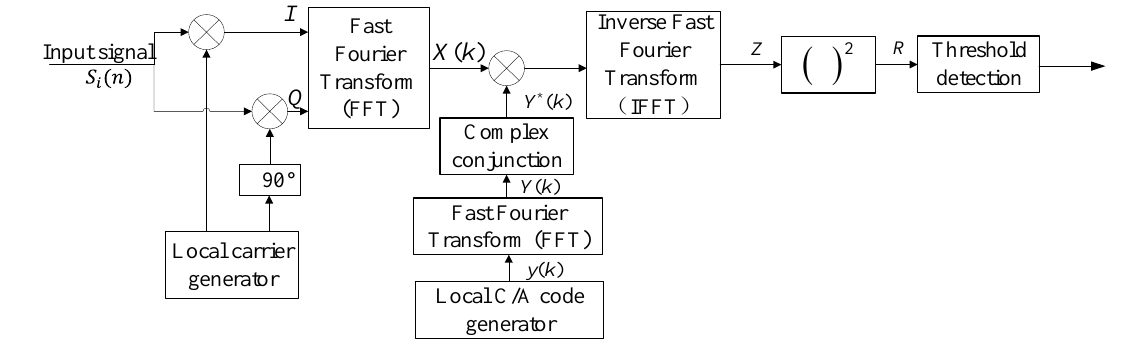
Figure 2. The schematic diagram of the parallel code phase search algorithm. The generated C/A code is transformed into the frequency domain and the result is complex conjugated.